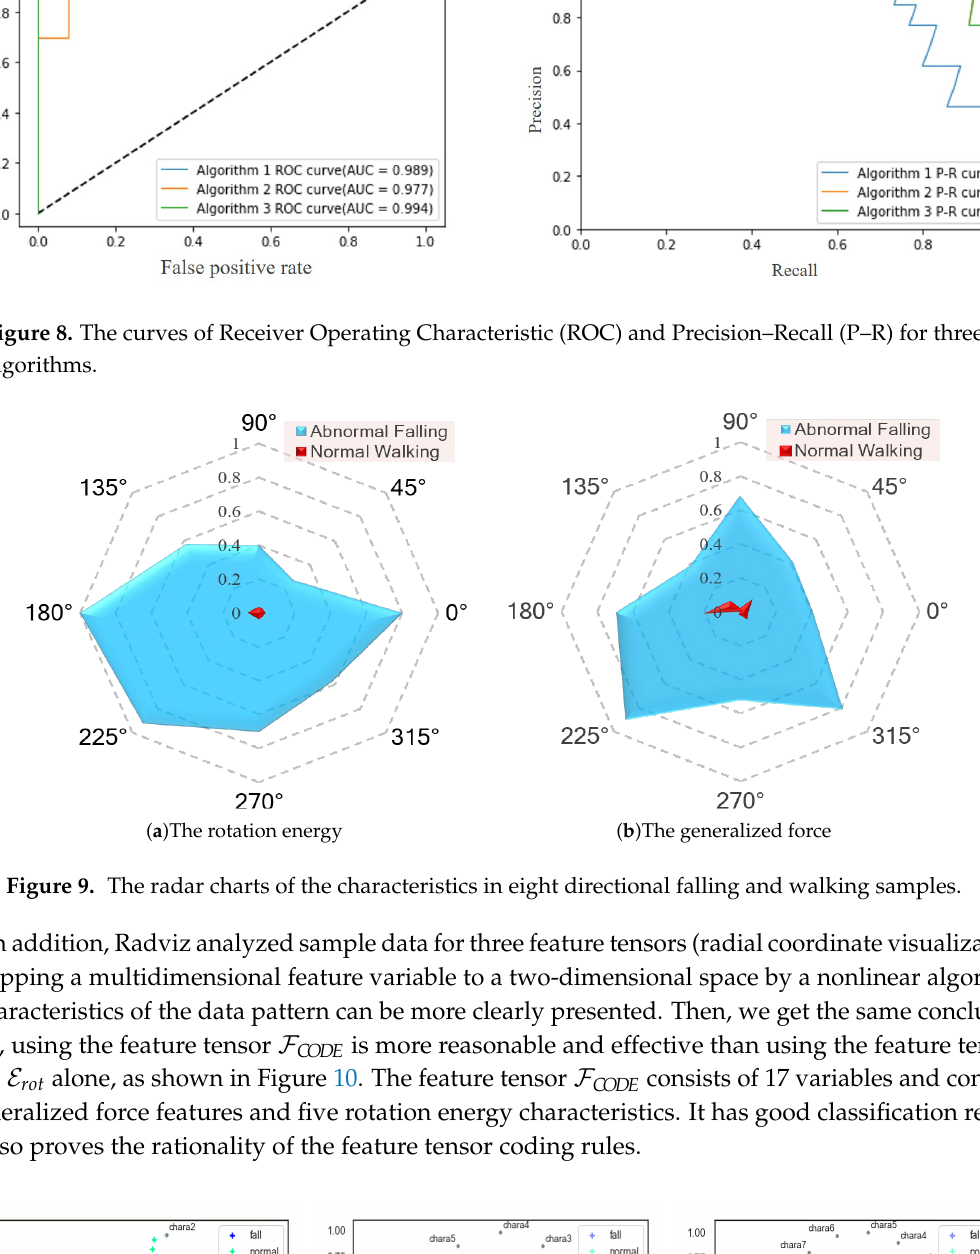
Algorithm 1 ROC curve(AUC = 0.989) -